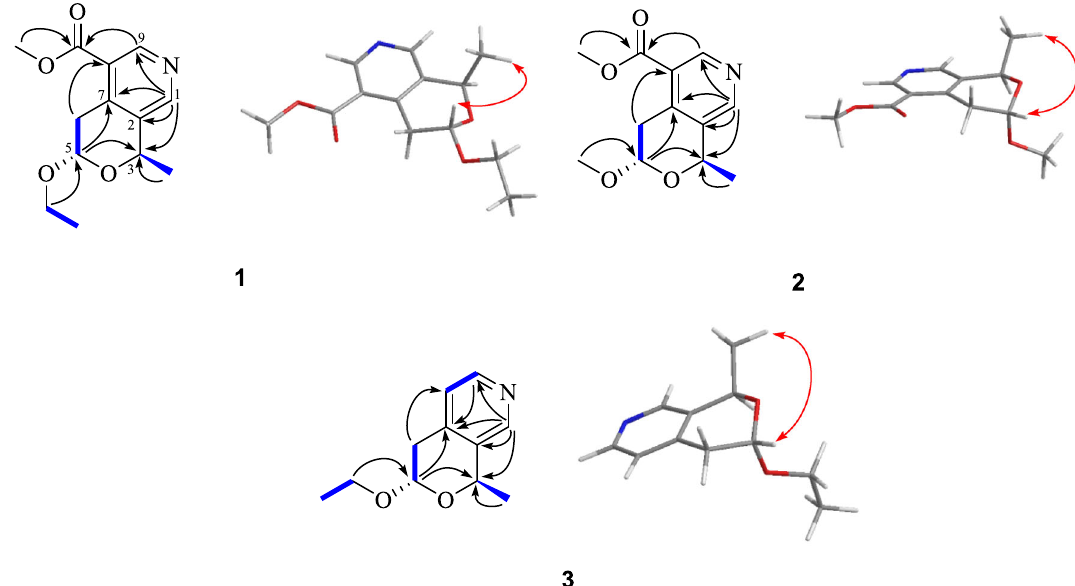
Fig. 2 Selective HMBC ( ? ), 1 H– 1 H COSY ( - ), and ROESY ( $ ) correlations for 1 – 3